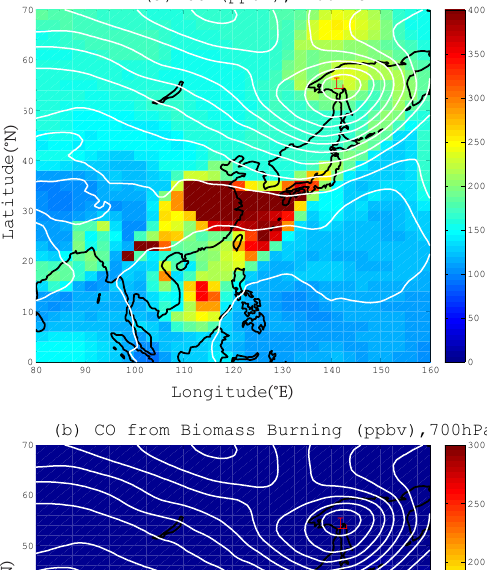
Figure 10. (a) CO, (b) CO from biomass burning, and (c) CO from the anthropogenic source on 17 March 2004 at 00:00 UTC, simu- lated by GEOS-Chem. The geopotential height at 700hPa is indi- cated with white contours. L indicates a low pressure system.